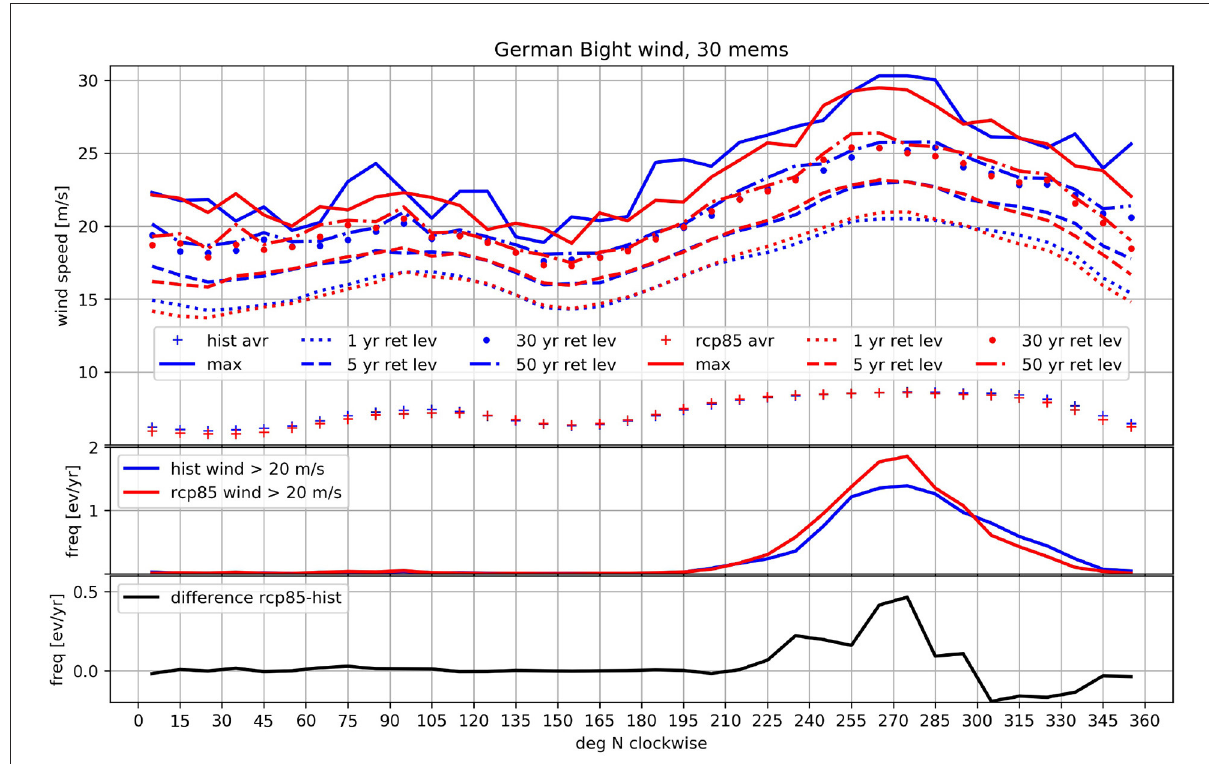
FIGURE8 Wind speed, direction, and frequency for the marine German Bight region from hist and rcp85 pools (blue and red colors, respectively). Wind data have been collected in 10 ◦ bins of the wind direction. (Upper) Average and maximum wind speed as well as 5-, 30-, and 50-year return levels in the bins. (Middle) Frequency in events per year for wind speeds above 20 m/s. (Lower) rcp85-hist difference of frequencies in (Middle)